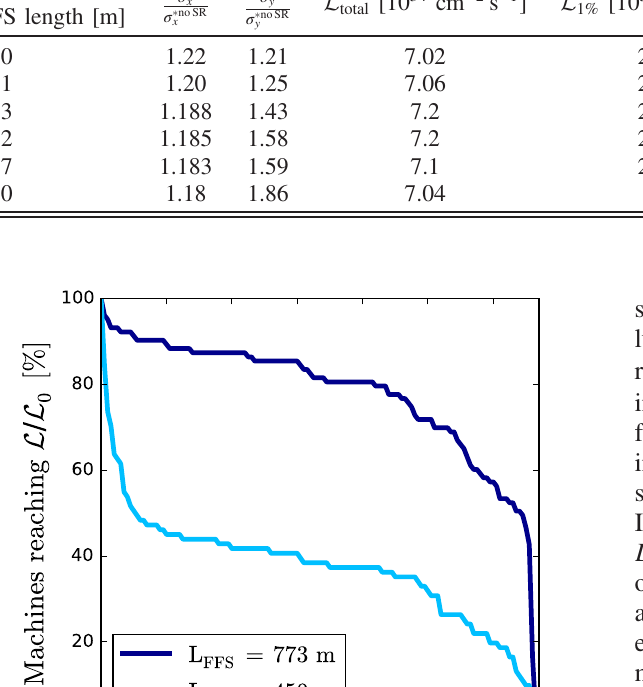
TABLE VIII. Luminosity performance and synchrotron radiation impact comparison for different FFS lengths with L (cid:1) ¼ 3 . 5 m. FFS length [m]